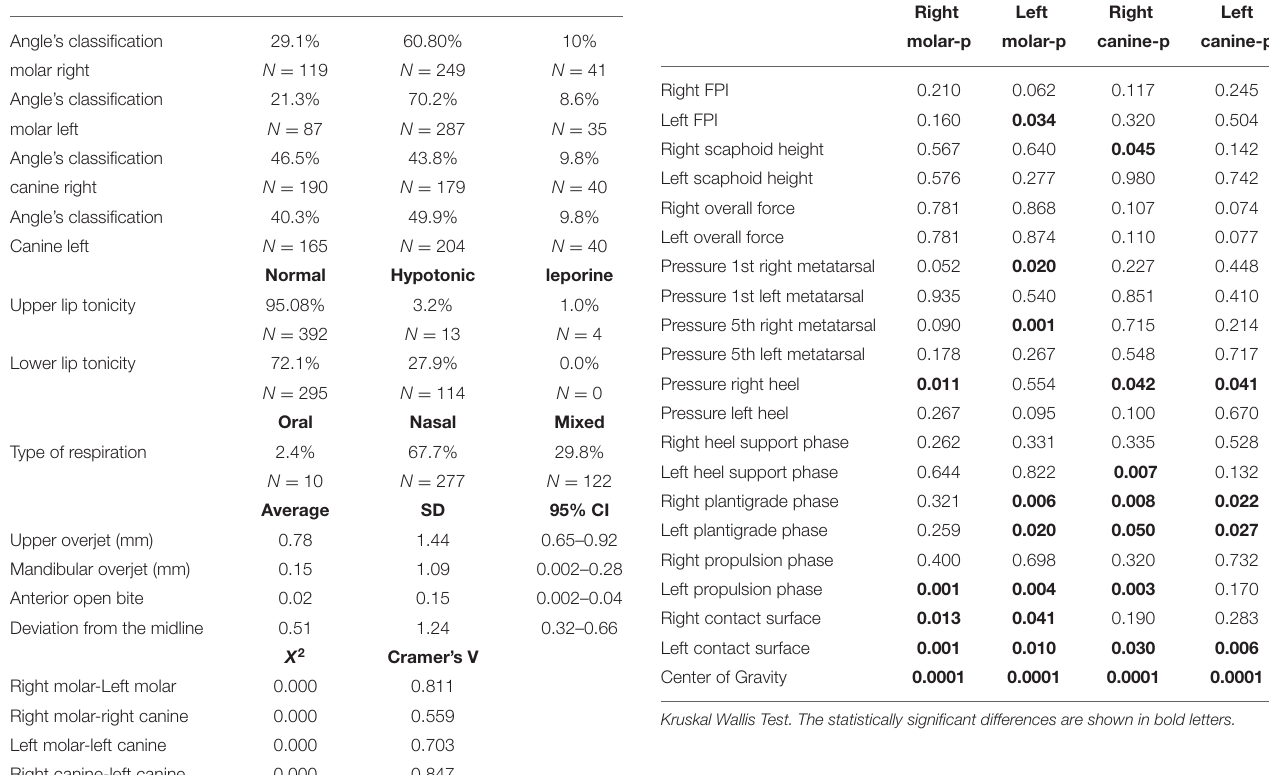
biomechanics. Right Left Right Left molar-p molar-p canine-p